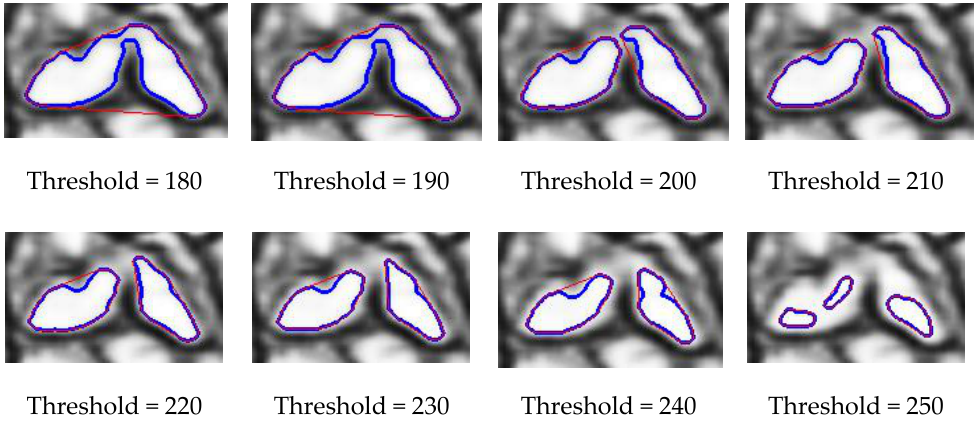
Figure 7. The separation process of an extracted image with two neighboring rocks. The contours are shown with blue lines and the convex hulls are shown by red lines.